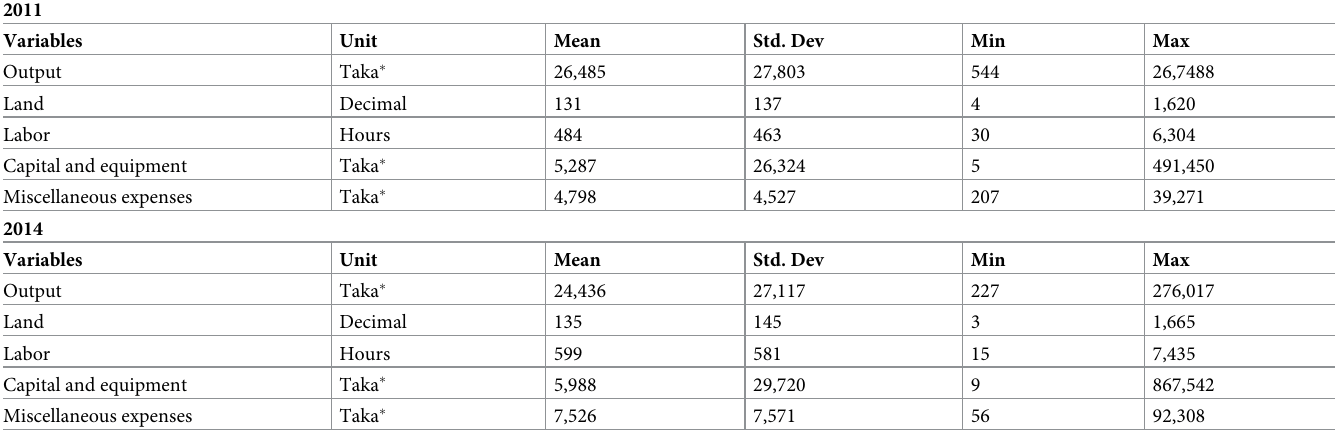
Table 1. Summary statistics of the deflated outputs and inputs of the sample